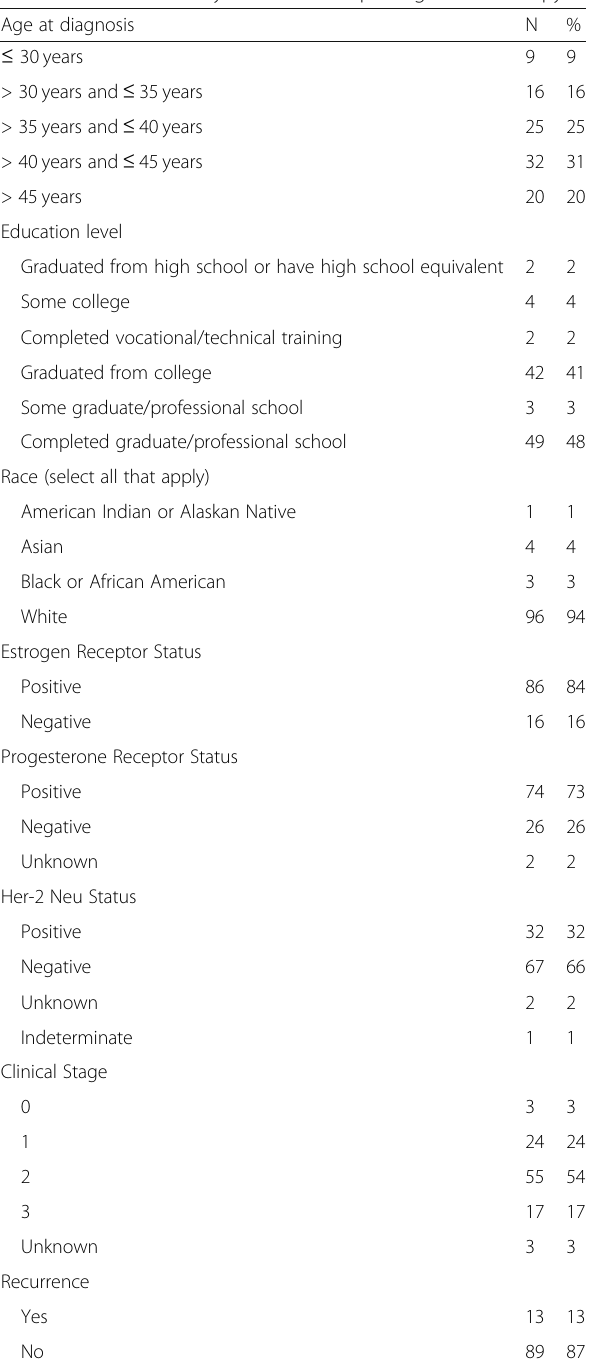
Table 1 Patient Characteristics for 102 women diagnosed with breast cancer under 50 years old and reporting